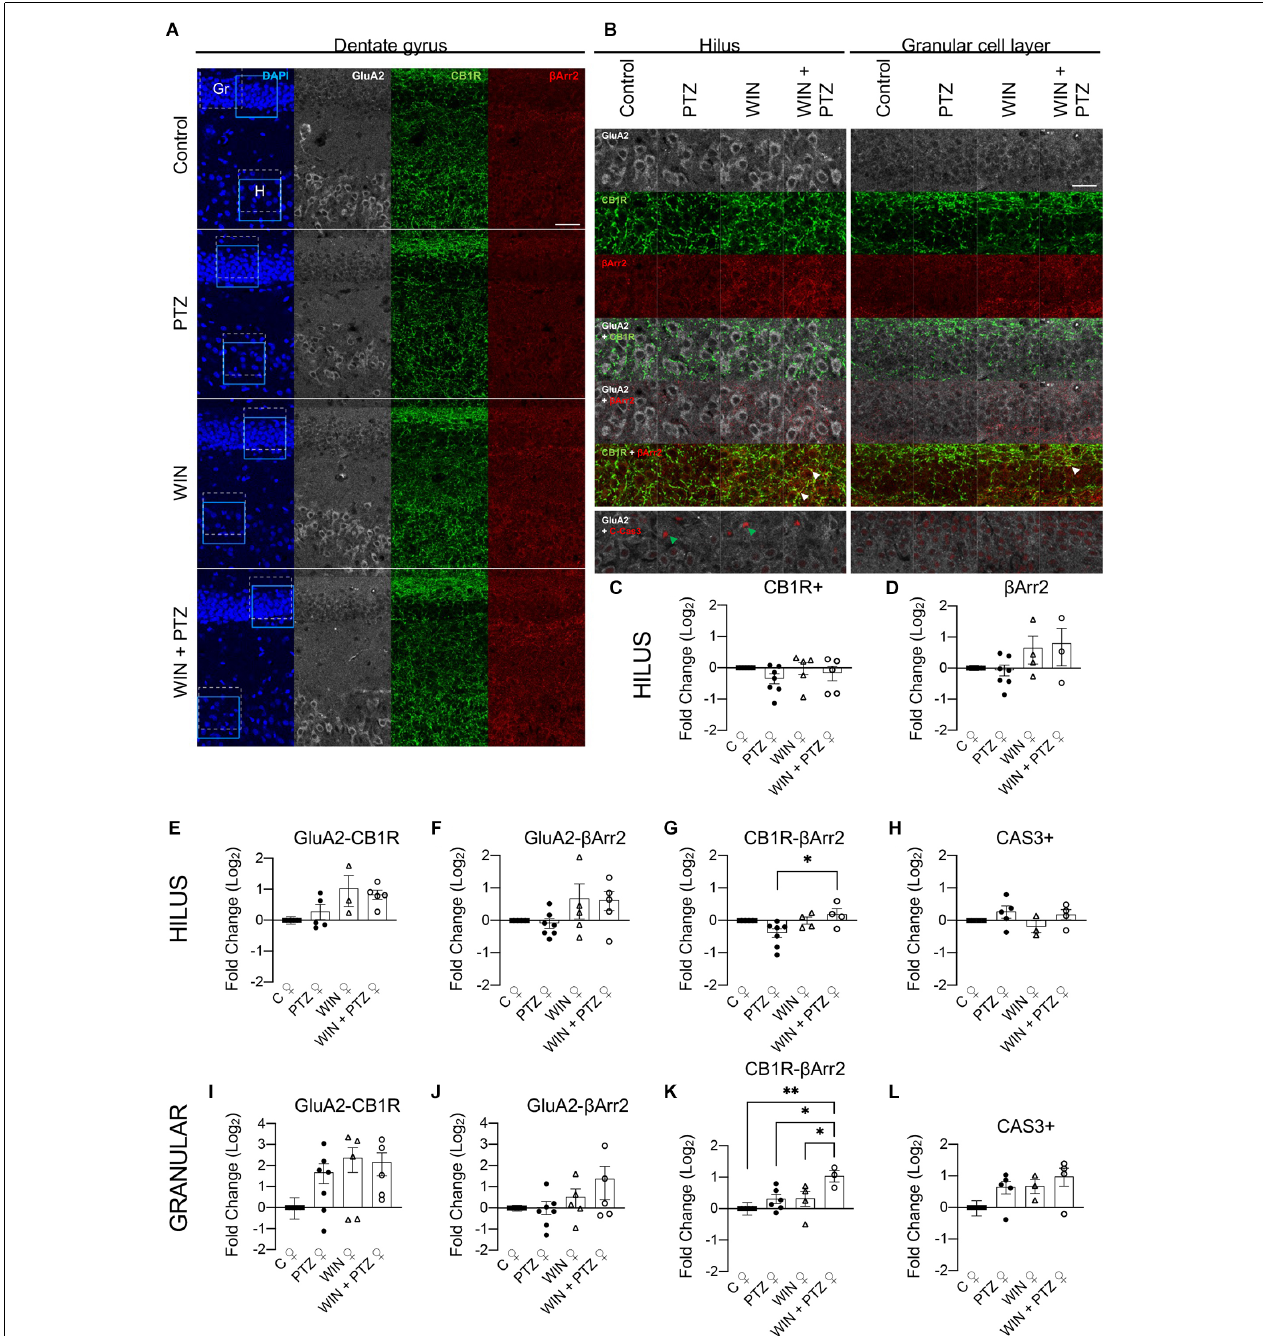
FIGURE 5 | Hilar and granule cell layer immunohistochemistry in female rats. (A) Representative immunofluorescent images of the dentate gyrus showing the granule cell layer (Gr) and the hilus (H) for each experimental group. Dashed square: areas used for colocalization analysis. Calibration bar: 40 µ m. (B) Representative images used for analysis [amplified view of dashed square region from (A) ]. Calibration bar: 25 µ m. (C–L) quantification of (B) . (C) CB1R + (C, n = 6; PTZ, n = 7; WIN, n = 5; WIN + PTZ, n = 5) and (D) β Arr2+ (C, n = 5; PTZ, n = 7; WIN, n = 4; WIN + PTZ, n = 3) area in the hilus. (E) GluA2-CB1R (C, n = 5; PTZ, n = 5; WIN, n = 3; WIN + PTZ, n = 5), (F) GluA2- β Arr2 (C, n = 5; PTZ, n = 7; WIN, n = 5; WIN + PTZ, n = 5) and (G) CB1R- β Arr2 (C, n = 5; PTZ, n = 7; WIN, n = 4; WIN + PTZ, n = 4) colocalization in hilus. (H) CAS3+ neurons (C, n = 4; PTZ, n = 5; WIN, n = 3; WIN + PTZ, n = 4) in hilus. (I) GluA2-CB1R (C, n = 5; PTZ, n = 7; WIN, n = 5; WIN + PTZ, n = 5), (J) GluA2- β Arr2 (C, n = 5; PTZ, n = 7; WIN, n = 5; WIN + PTZ, n = 5), and (K) CB1R- β Arr2 (C, n = 5; PTZ, n = 6; WIN, n = 4; WIN + PTZ, n = 3) colocalization in the granular cell layer. (L) CAS3+ neurons (C, n = 4; PTZ, n = 5; WIN, n = 3; WIN + PTZ, n = 4) in granular cell layer. White arrows: examples of strong colocalization between CB1R and β Arr2. Green arrows: example of CAS3+ cells. ∗ p < 0.05 and ∗∗ p < 0.01, one-way ANOVA with Tukey’s multiple comparisons post hoc .